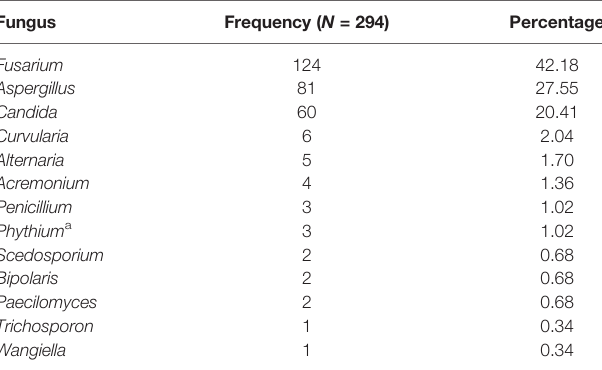
TABLE 7 | The spectrum and frequency of various fungi isolated from keratoplasty patients with fungal keratitis and identi fi ed at the genus level during 1990 to 2020 (294 out of 379 isolates have been identi fi